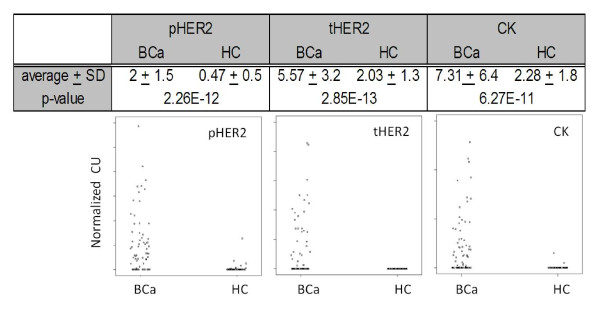
CTC-HER2 profiling in BCa patients and HCs. The p-values were calculated using a two-sided Wilcoxon rank sum test, a nonparametric test similar to a t-test. All of the comparisons show a statistically significant difference (p < 0.01). To determine pHER2 and tHER2 status, the background and reference values was subtracted (normalized CU). Scatter plots of normalized CU for pHER2, tHER2 and CK for BCa's and HC's are shown.